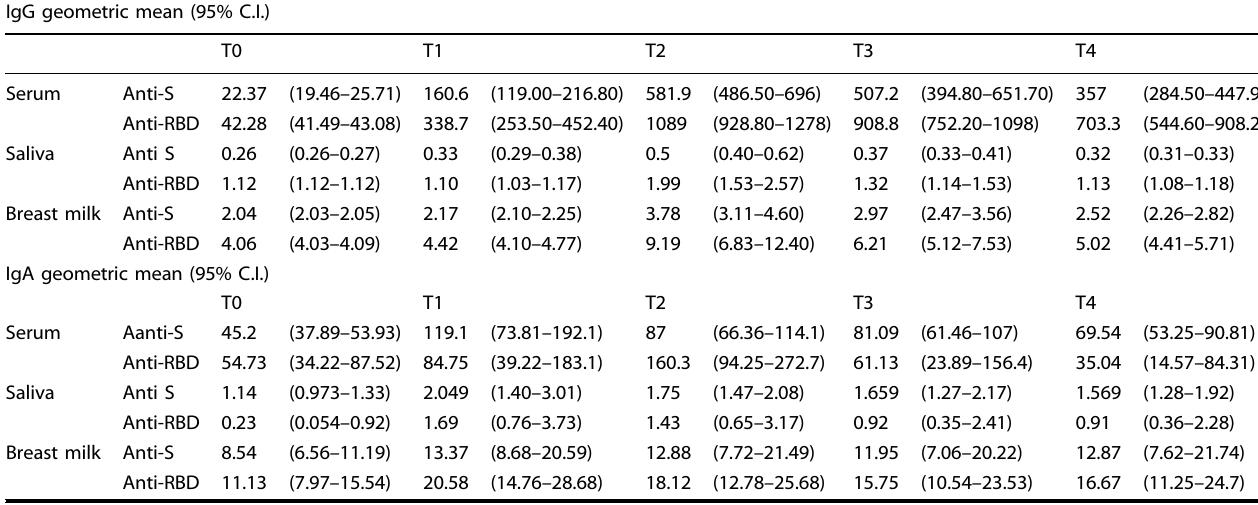
Table 2. Geometric means and 95% C.I. of antibody titers (IU/mL) in the maternal specimens analyzed a . IgG geometric mean (95% C.I.)